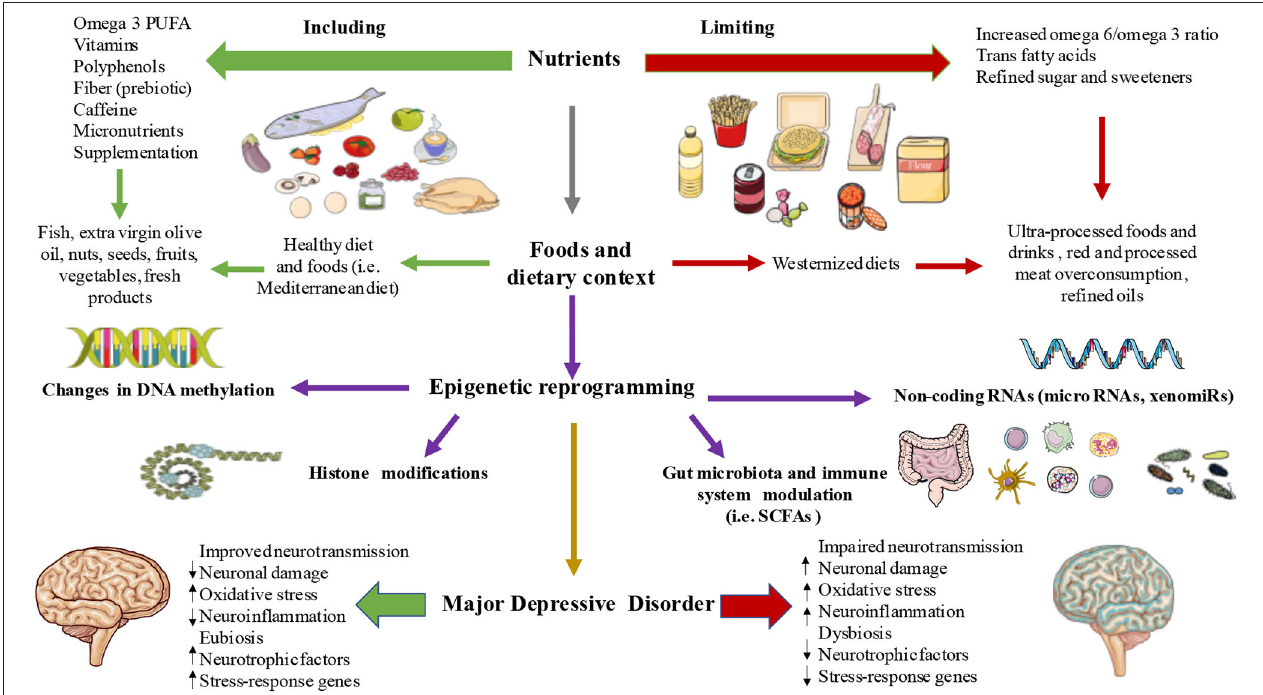
FIGURE 2 | The link between diet, epigenetics, and MDDs. As summarized, a set of nutrients, foods, and dietary strategies are able to influence different epigenetic mechanisms like DNA methylation, histone modifications, non-coding RNAs, and gut microbiota-immune system composition and their products thereby influencing in the pathophysiology of